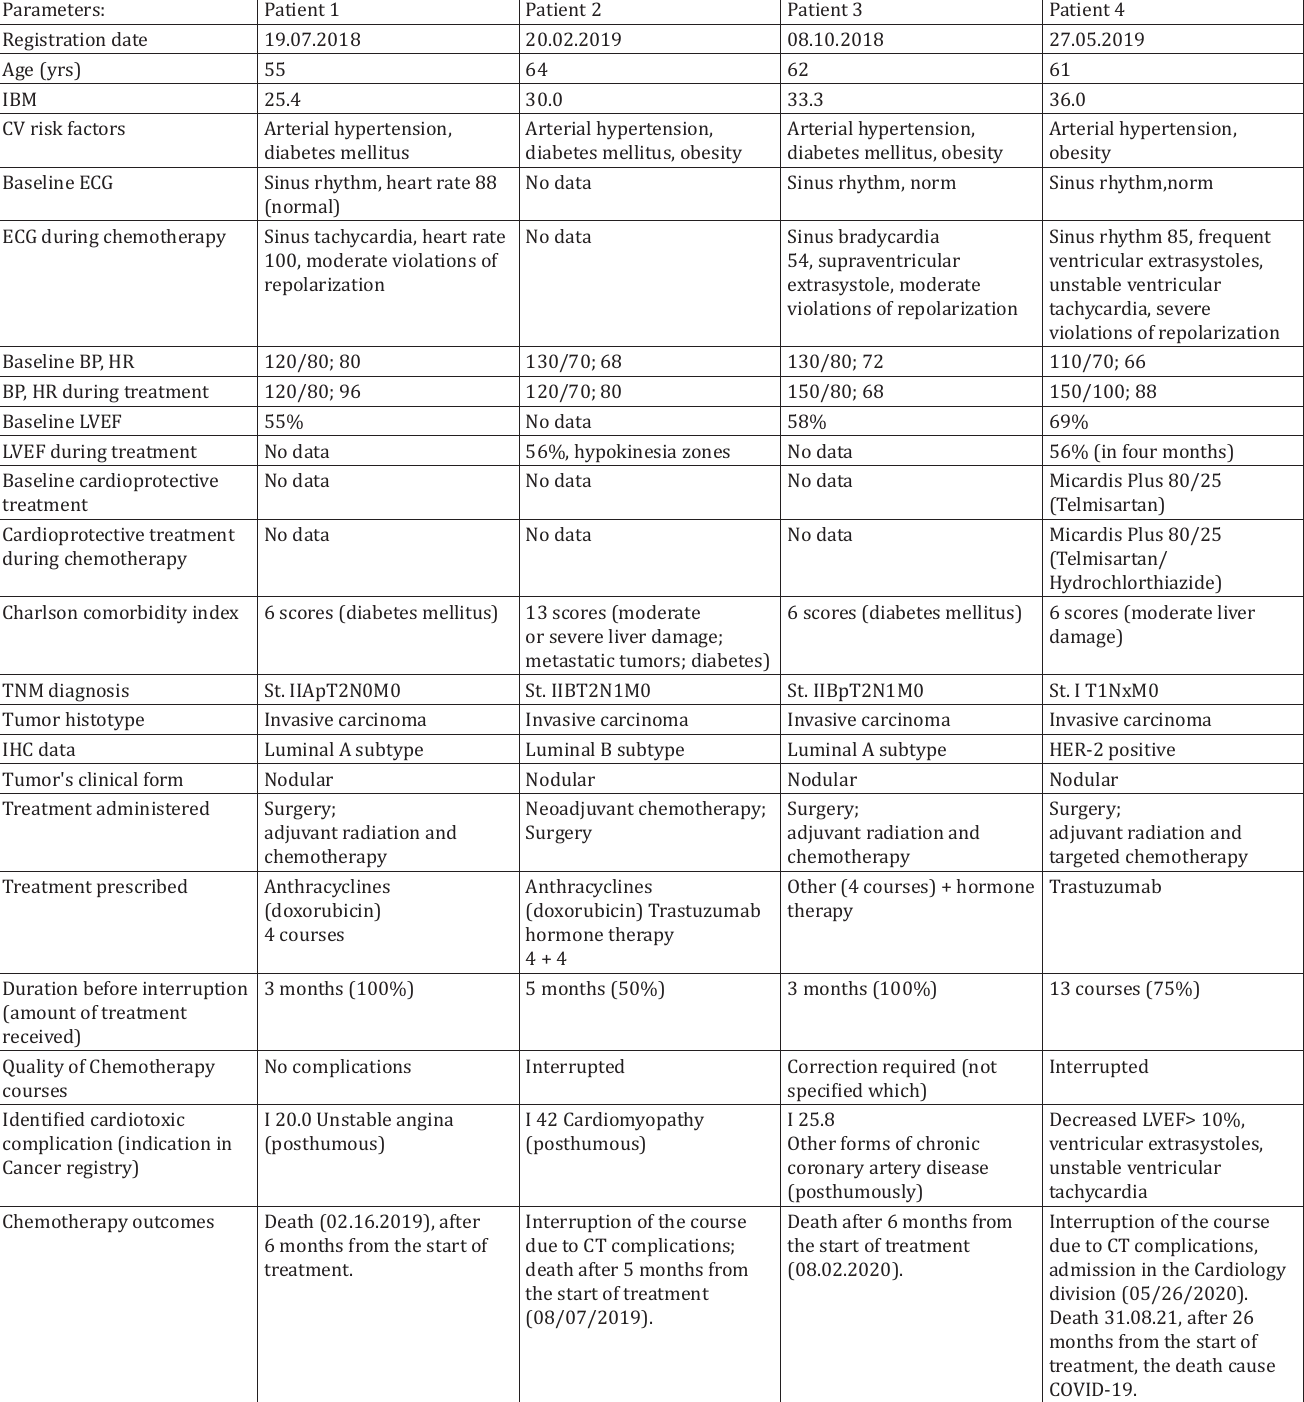
Data of patients where cardiotoxicity of chemotherapy was revealed